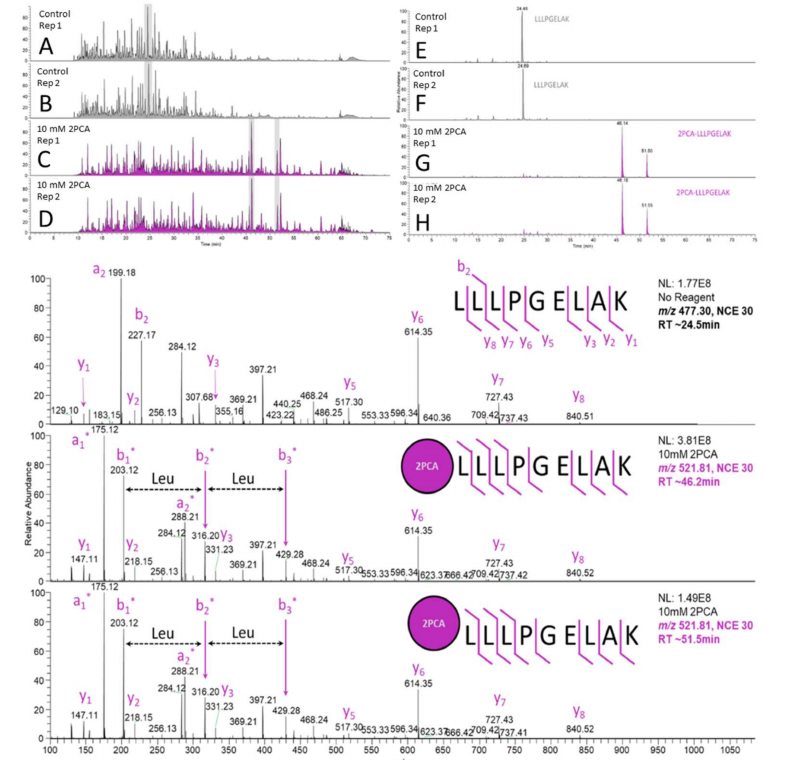
Figure 1. Base peak chromatograms of a HeLa S9 whole cell lysate digest that underwent the entire derivatization procedure in the absence (chromatograms A and B ) and in the presence of the 2PCA reagent (chromatograms C and D ). The extracted ion chromatograms ( E – H ) of the most abundant peptides are shown on the right, which showcase their retention time shift and isomerization as a function of 2PCA derivatization. The annotated tandem mass spectra of the most abundant observed peptide and its derivatized versions obtained at both retention times are shown